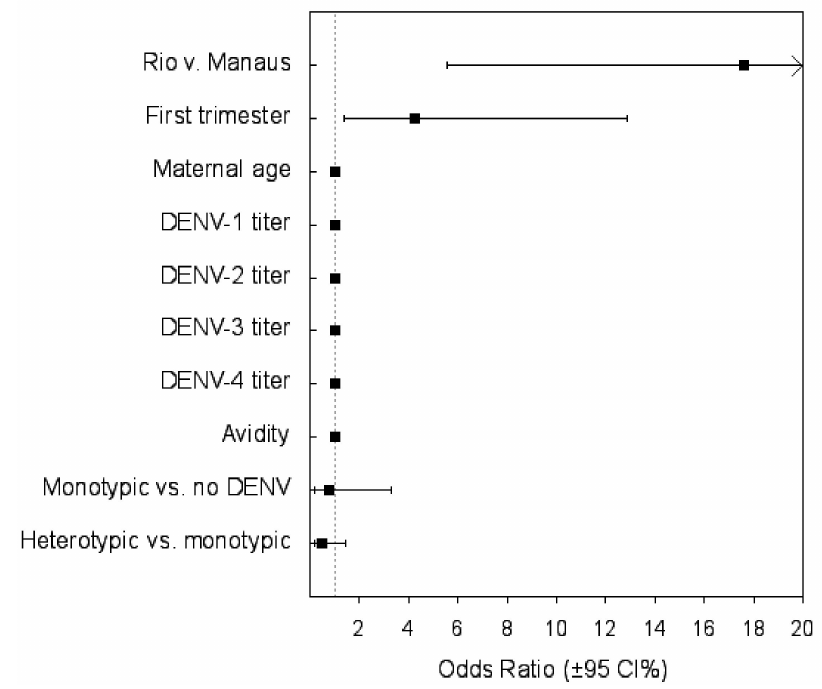
Figure 2. Risk factors for infant abnormalities at delivery ( N =